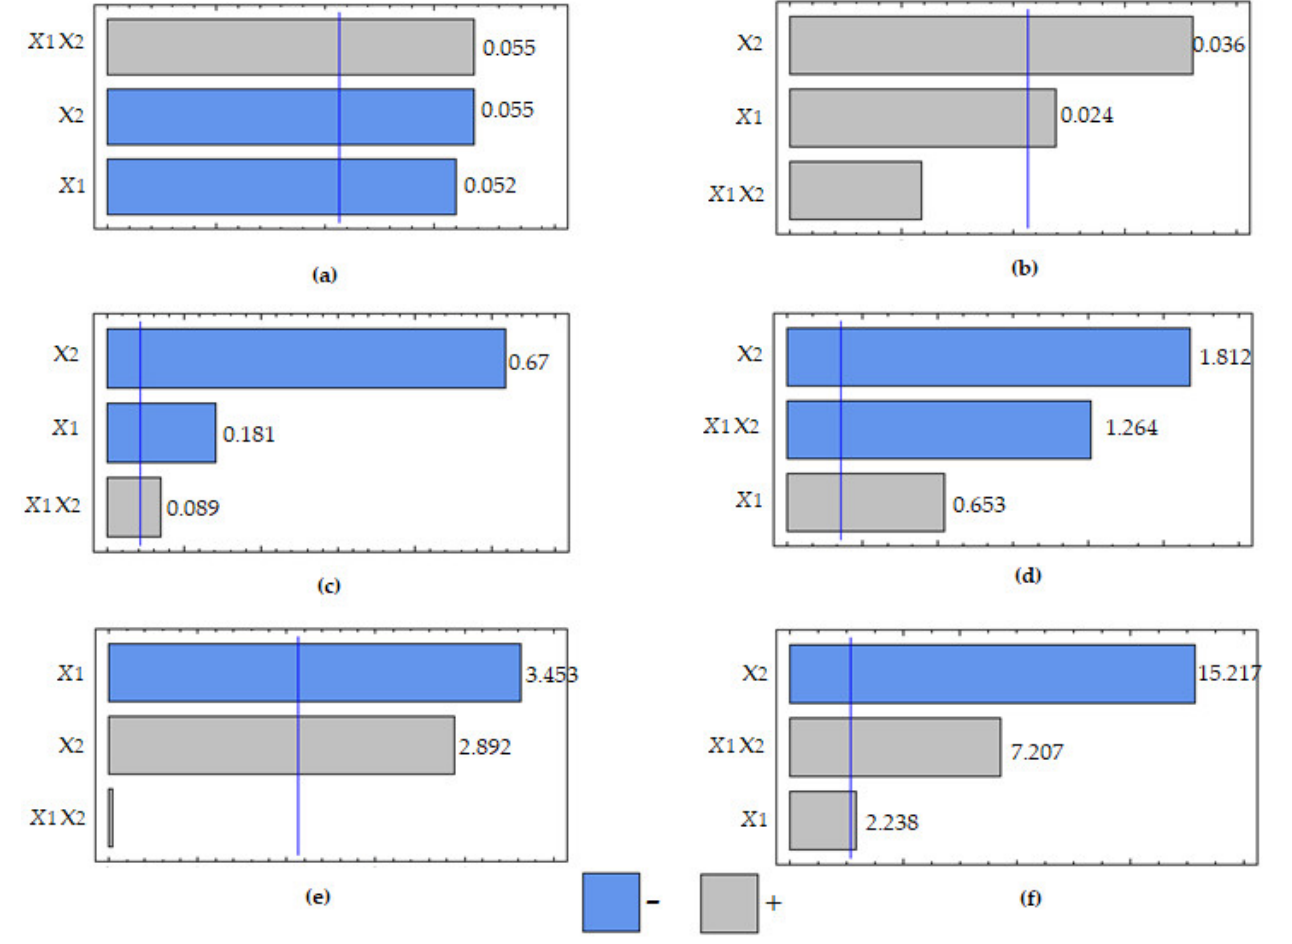
Figure 1. Standardized Pareto charts for the effects of the amount of goji berry ( X 1 ) and feed moisture content ( X 2 ) on the physical and functional characteristics (( a ): ER; ( b ): B; ( c ): WAI; ( d ): WSI; ( e ): HD; ( f ): SME). The vertical line in the chart tests the significance of the effects at a level of significance = 0.05.